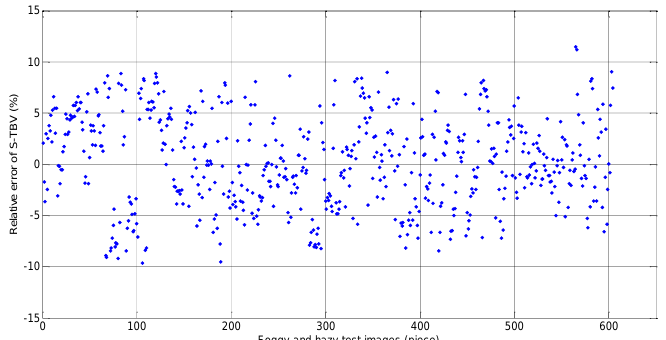
Figure 9. Relative errors of the TBV approach in detail. (The training set and the testing set are separated. A total of 604 foggy and hazy images are tested. There are only two relative errors which are between 11% and 12%. The other errors are less than 10%. Relative errors of 414 foggy and hazy images are less than 5%.)